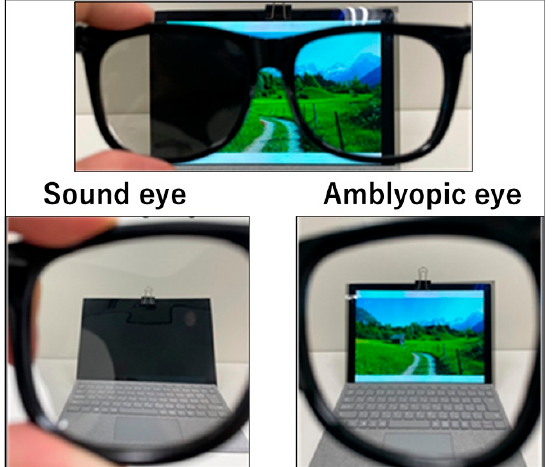
Figure 3. The dichoptic treatment method used in the study. A polarizing film was attached to the monitor for amblyopia treatment, and another polarizing film was attached to the eyeglasses on the sound eye side so that the absorption axes of the films were perpendicular to each other. No polarizing film was attached to the side of the eye with amblyopia. Thus, only the eye with amblyopia could see the monitor when both eyes were open.